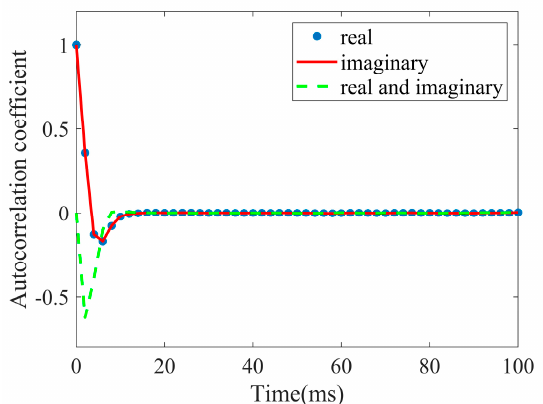
Figure 6. Autocorrelation and cross-correlation coefficients of real and imaginary parts of the speckle component.